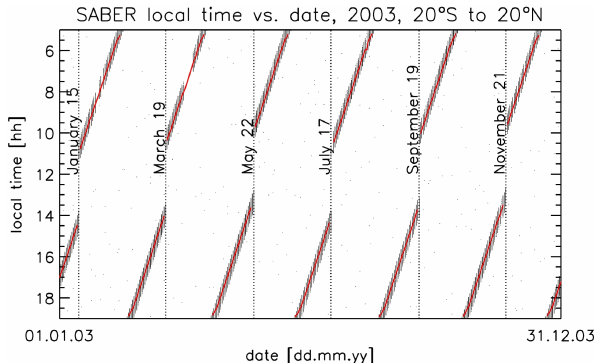
Fig. 2. Distribution of solar local times of SABER measurements between 20 ◦ S and 20 ◦ N for the year 2003. Each dot represents one profile. The vertical dotted lines with dates indicated mark yaw maneuvers. The red line shows daily mean of the solar local time of measurements.